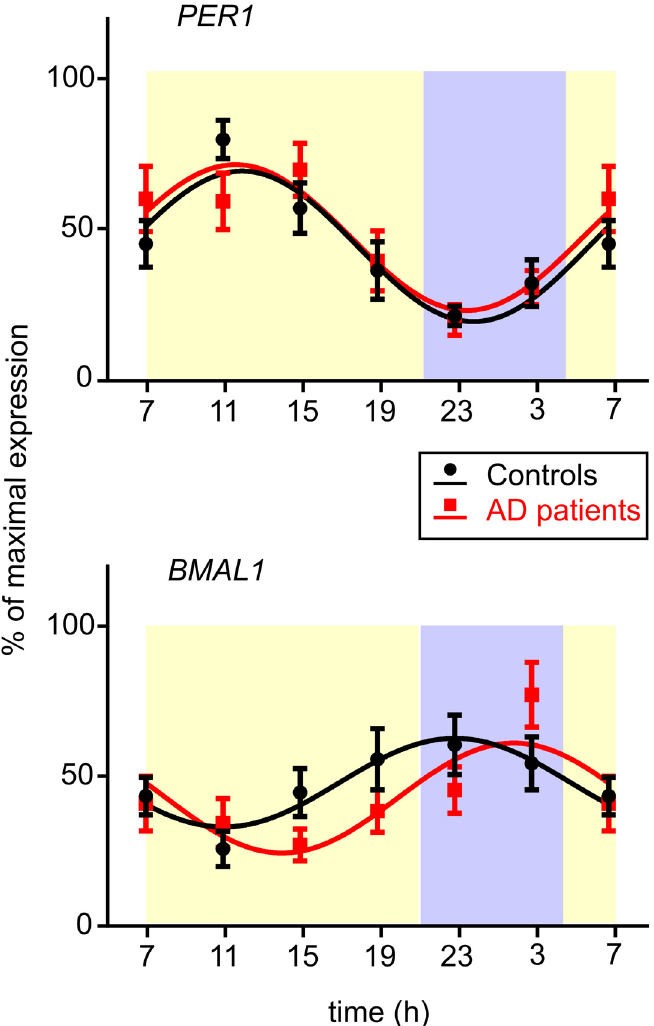
Fig 6. Daily profiles of clock gene expression in buccal cells of controls and AD patients. PER1 (upper graph) and BMAL1 (lower graph) expression profiles were compared in controls (black circles, n = 13) and AD patients (red squares, n = 13). Data are expressed as % of maximal expression levels (means ± S.E.M.) and fitted with cosine curves (controls: black curves, AD patients: red curves). The X-axes represent the time of day in